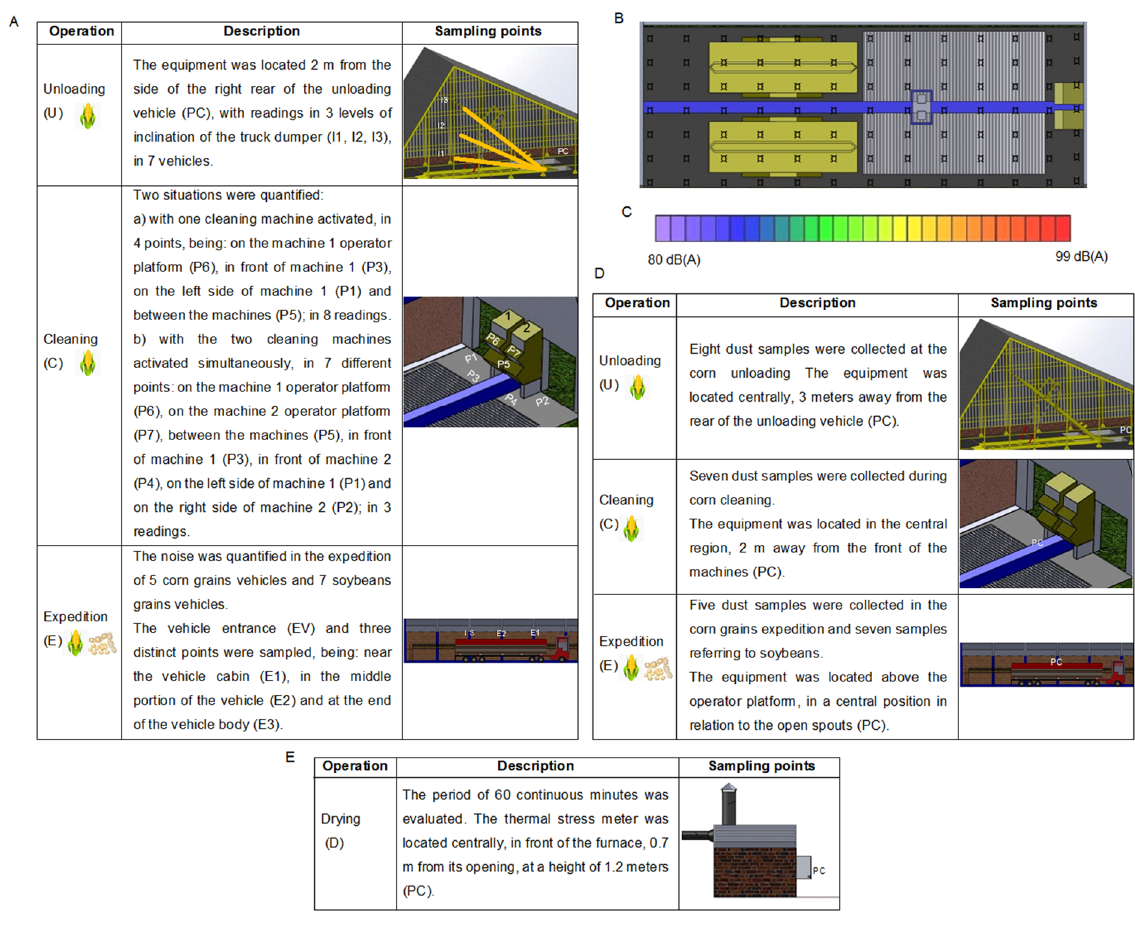
Figure 2. Representation of noise data collection points ( A ), noise collection points in top view of the grain receiving and cleaning area ( B ), noise colorimetric scale ( C ), representation of dust data collection points ( D ), representation of heat stress data collection points ( E